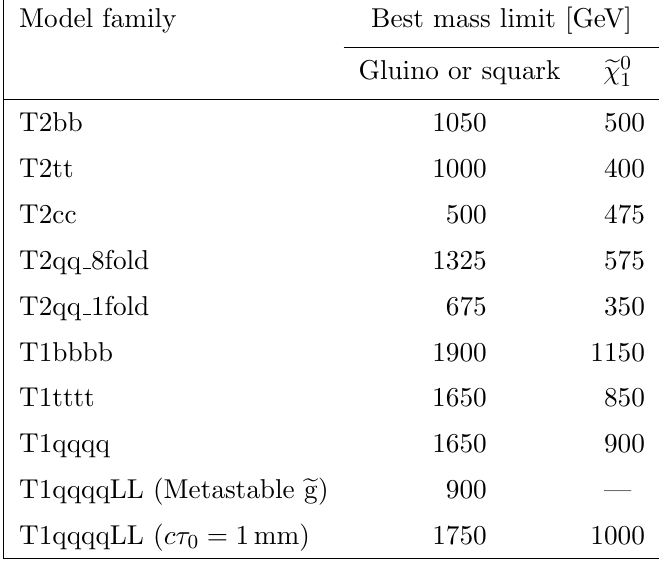
Table 5 . Summary of the mass limits obtained for each family of simpli(cid:12)ed models. The limits indicate the strongest observed mass exclusions for the parent SUSY particle (gluino or squark) and (cid:31) 0 e 1